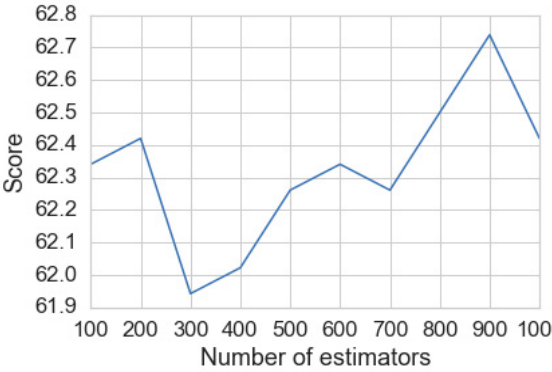
Figure 13. The random forest accuracy (identified as score), based on the estimators’ numbers.